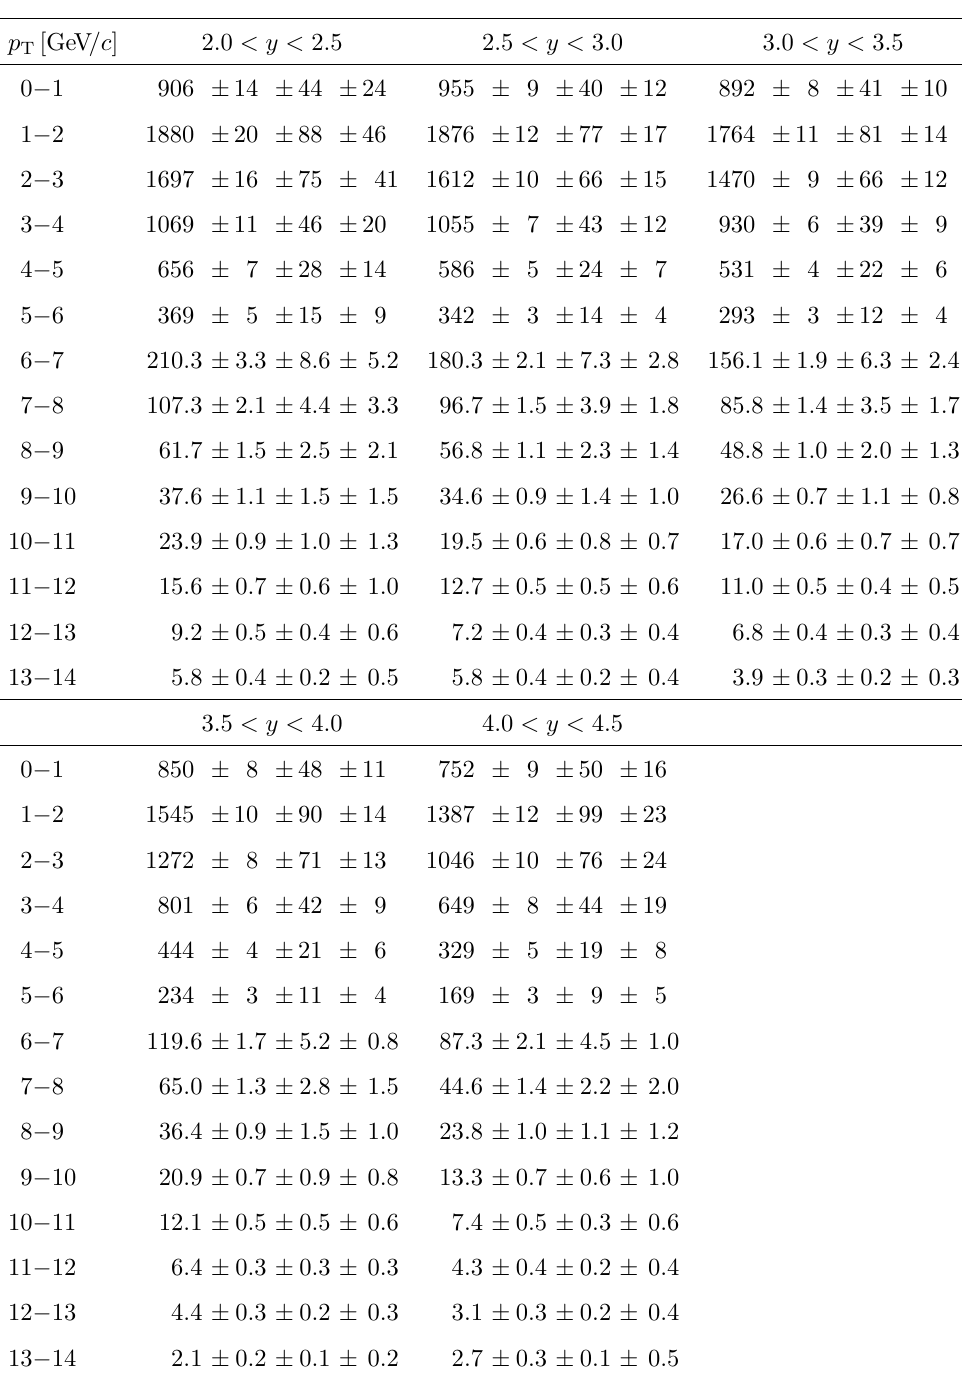
Table 2 . Double di(cid:11)erential production cross-section in nb = (GeV =c ) for prompt J= mesons